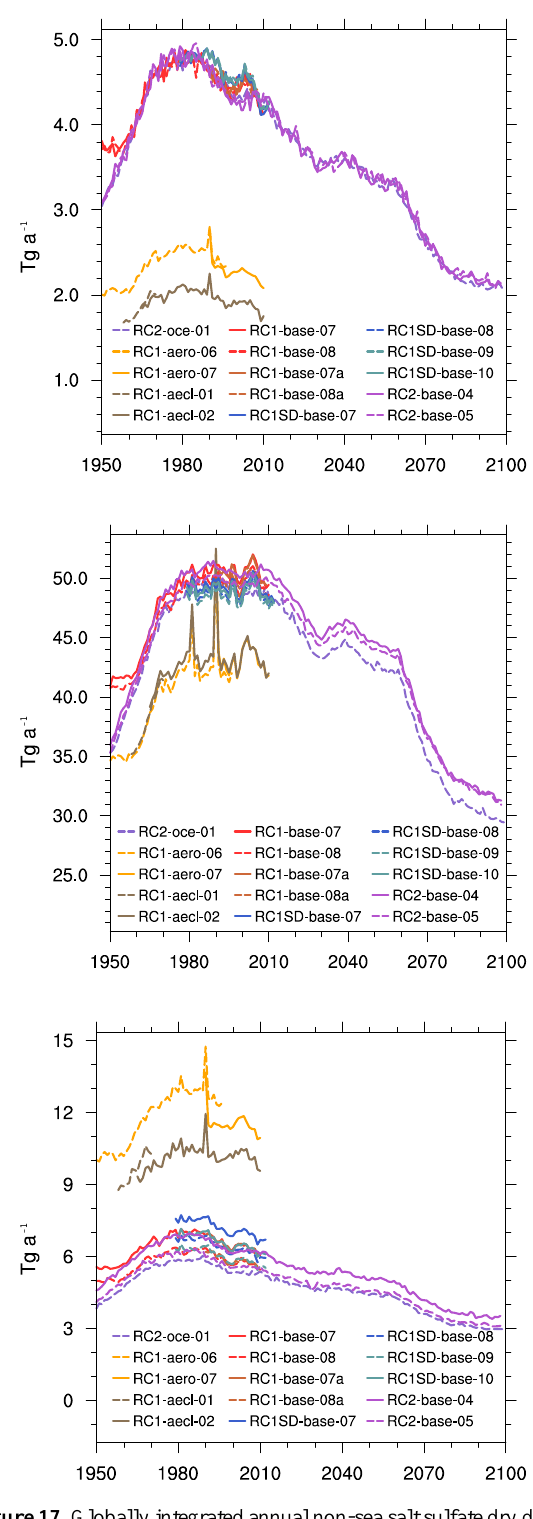
Figure 17. Globally integrated annual non-sea salt sulfate dry depo- sition (upper), wet deposition (middle), and sedimentation (lower) fluxes in Tg ( S ) a − 1